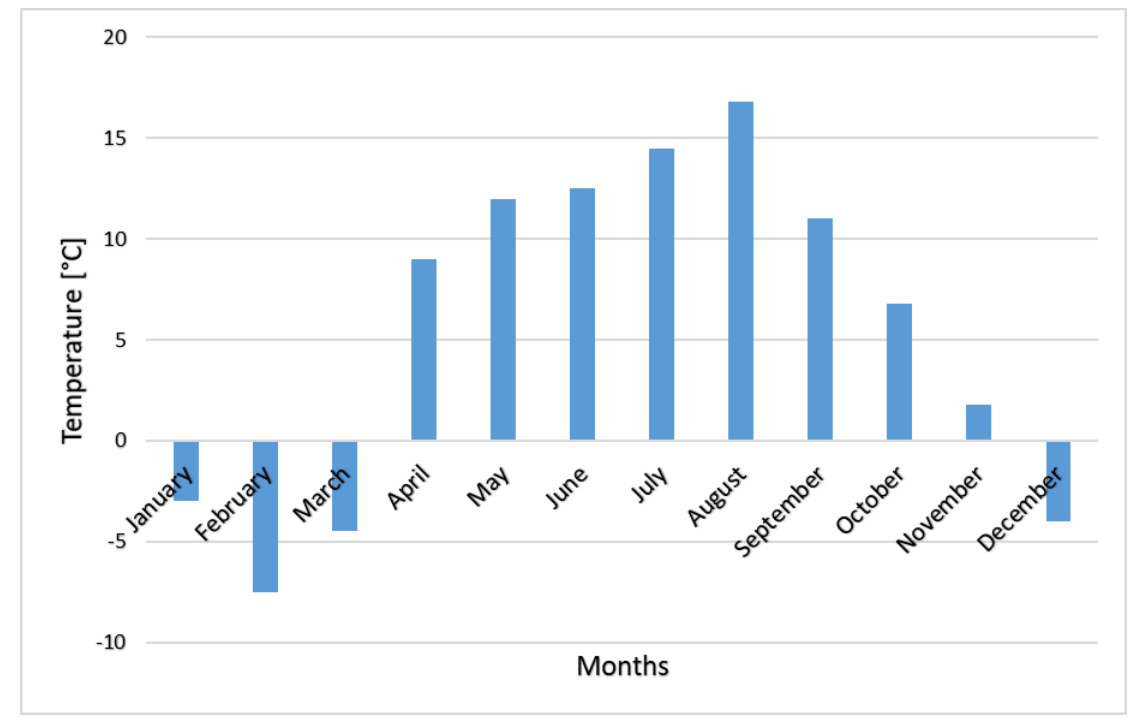
Figure 2. Climate areas according to the Quitt classification (adjusted by [15]).